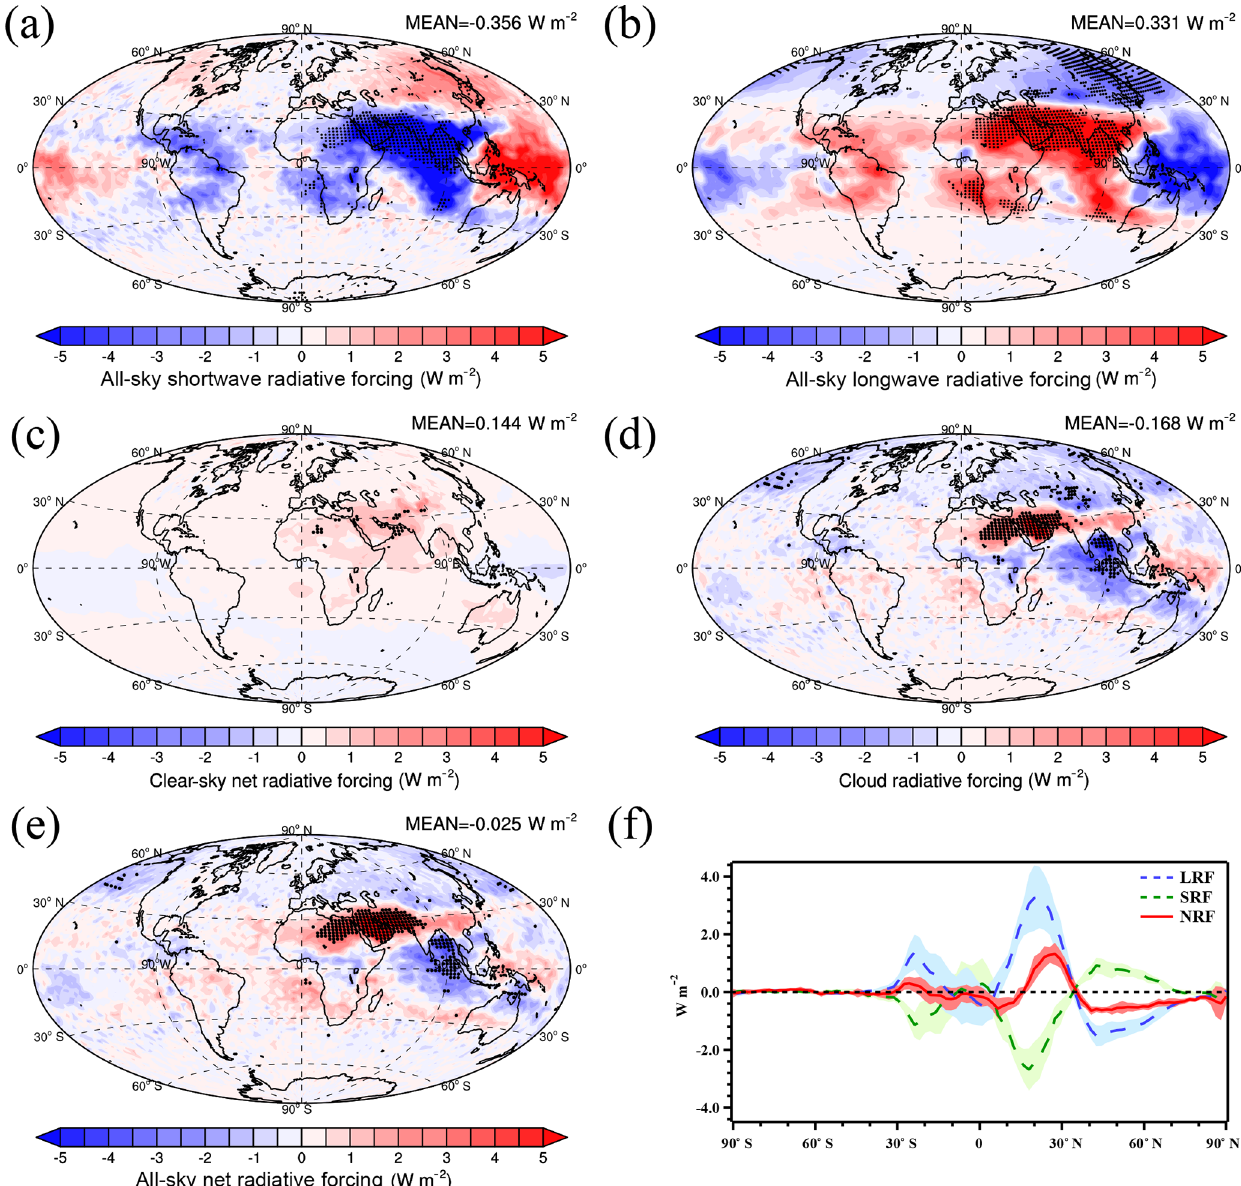
Figure 8. As in Fig. 7 but for the difference between the PD_Base and PI_SO4 cases. Differences significant at the 90% level according to a Student’s t test are depicted by points. The shading in (f) represents 1 standard deviation of the interannual variation over 6 years.